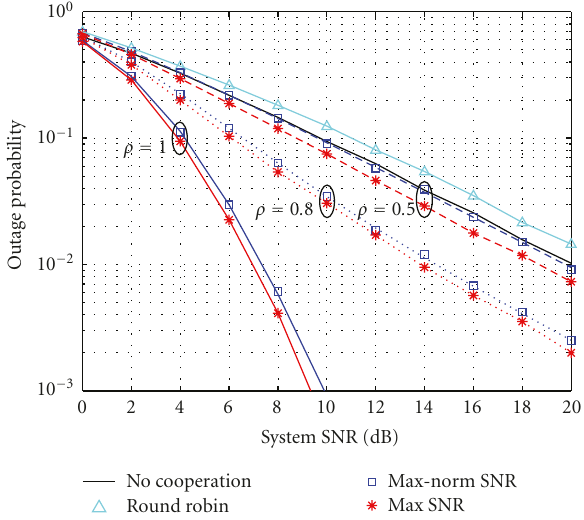
Figure 3: Outage probability versus system SNR for the di ff erent communication strategies and values of ρ . For the max-normalized SNR strategy, symbols are associated with the simulated results whereas lines correspond to the theoretical expression. ( K = 5 relays, R = 1bit/s/Hz, d = 100